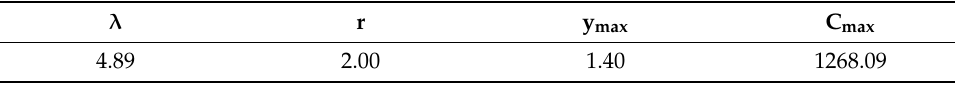
Table 3. Coefficients of flood damage cost function.